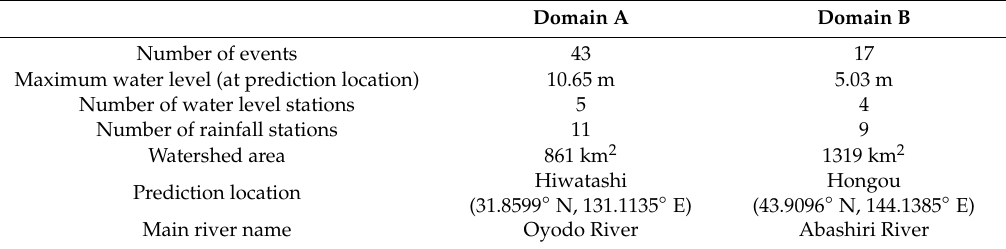
Table 3. Characteristics of the two